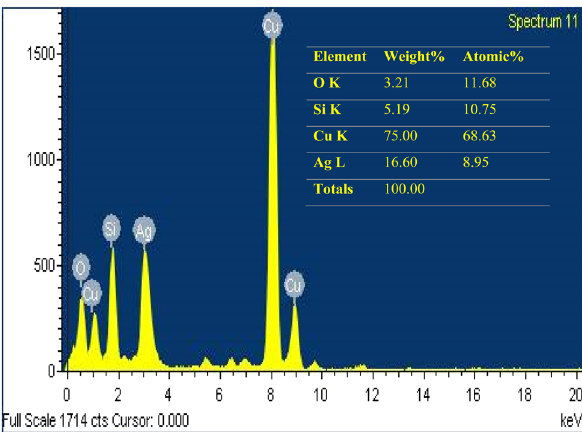
Figure 3: EDX spectrum of synthesized Cs -